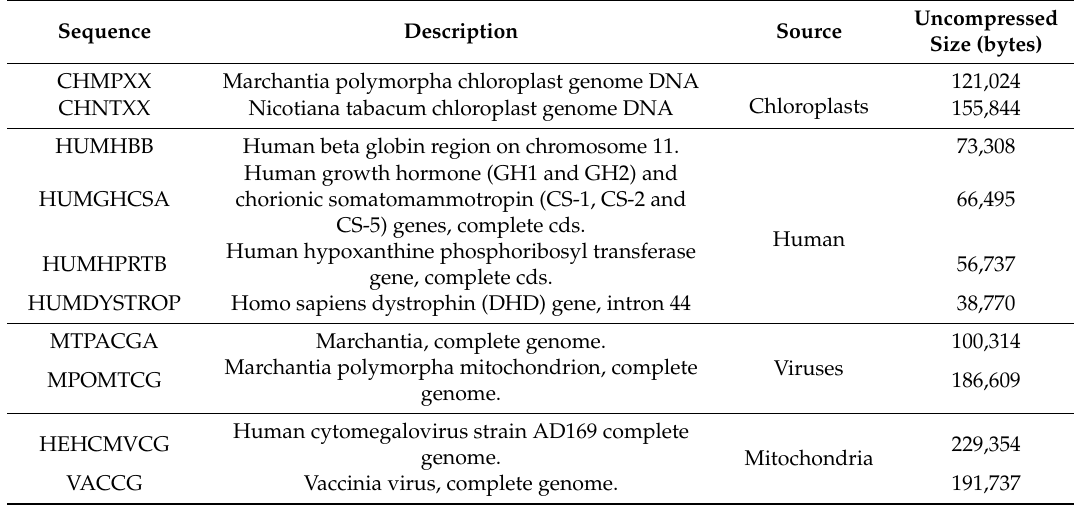
Table 1. A selected DNA dataset.